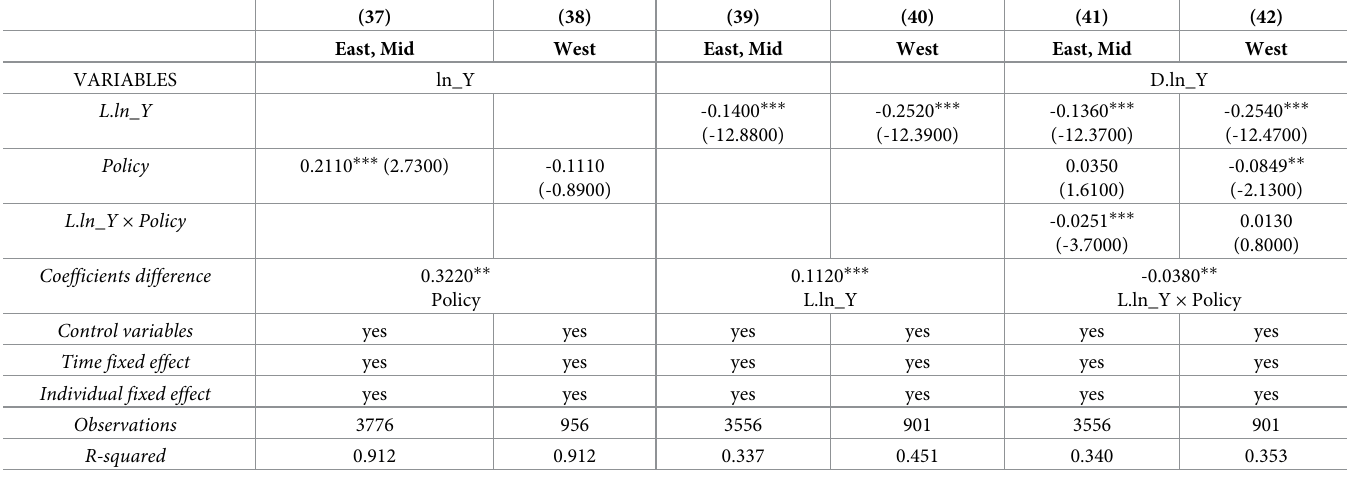
Table 9. Regional heterogeneity test (basic effect and convergence